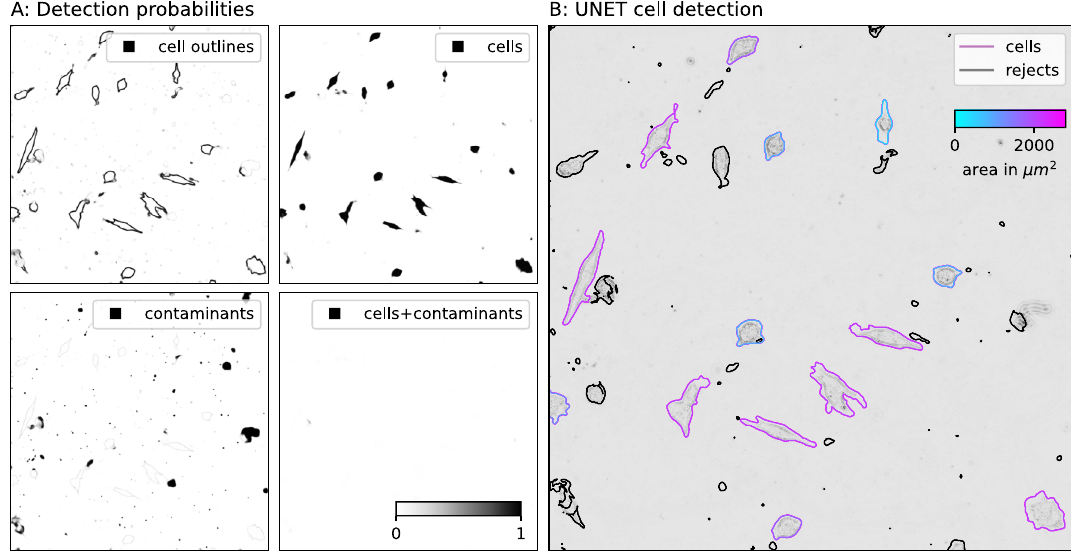
Figure 6. Inference example of the U-Net segmentation approach. ( A ) the probability maps for the individual segmentation groups. ( B ) evaluated cells’ true positives (shades of blue and purple) and rejected objects - true negatives (black outline), which are either contaminants of cells that are not present during the entire observation